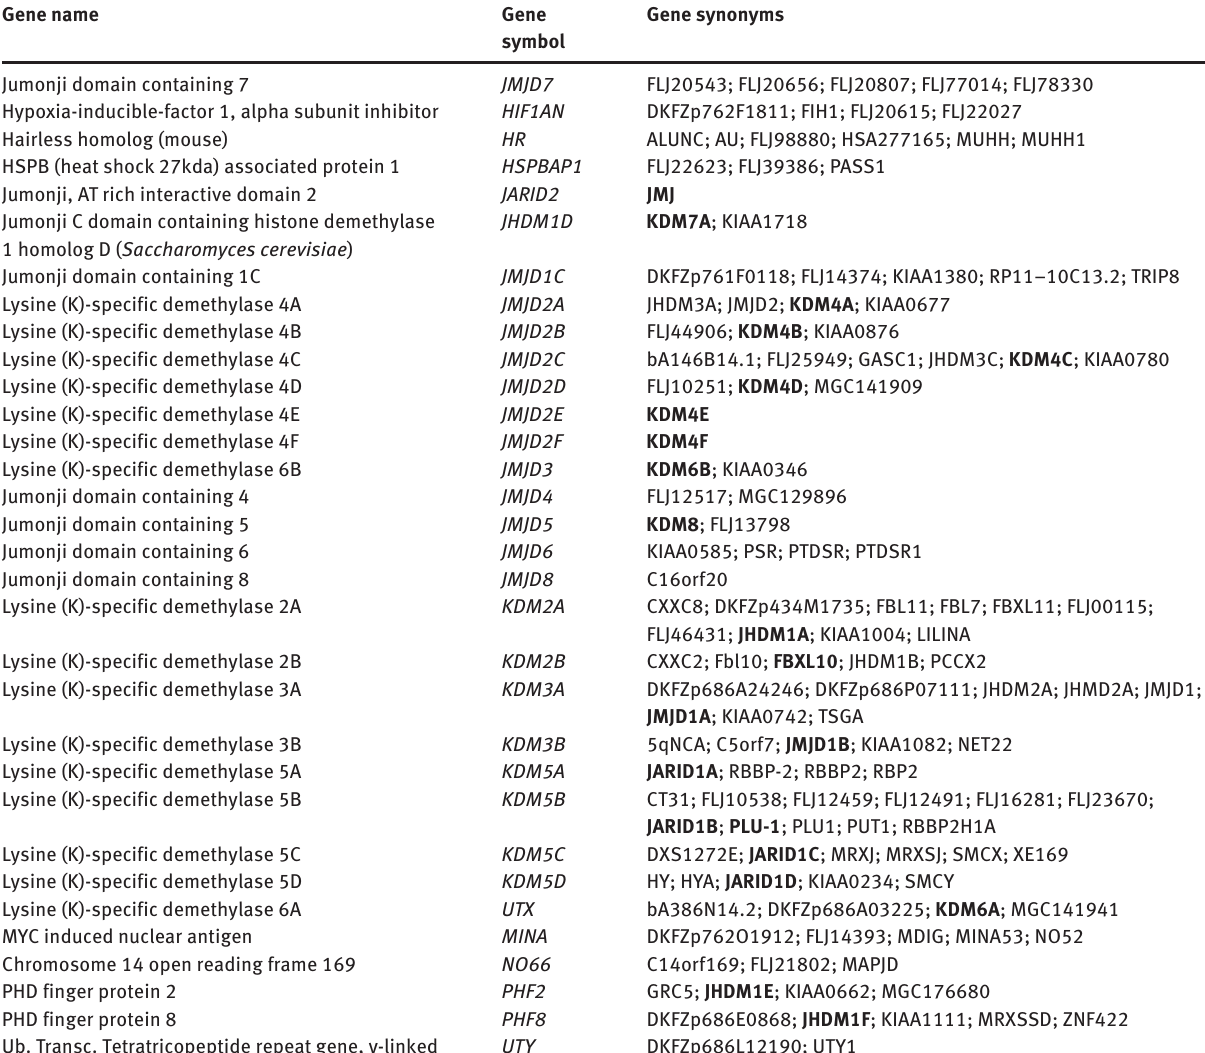
Table 1 Gene names, symbols and synonyms of JmhC